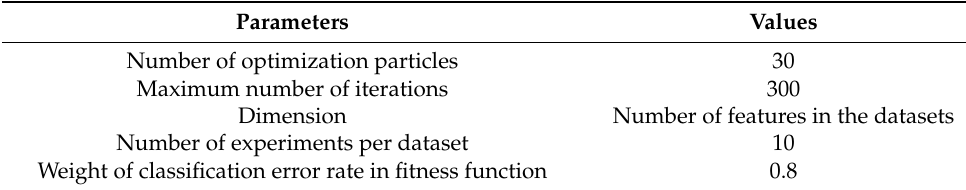
Table 3. Parameters in the MetaSCA